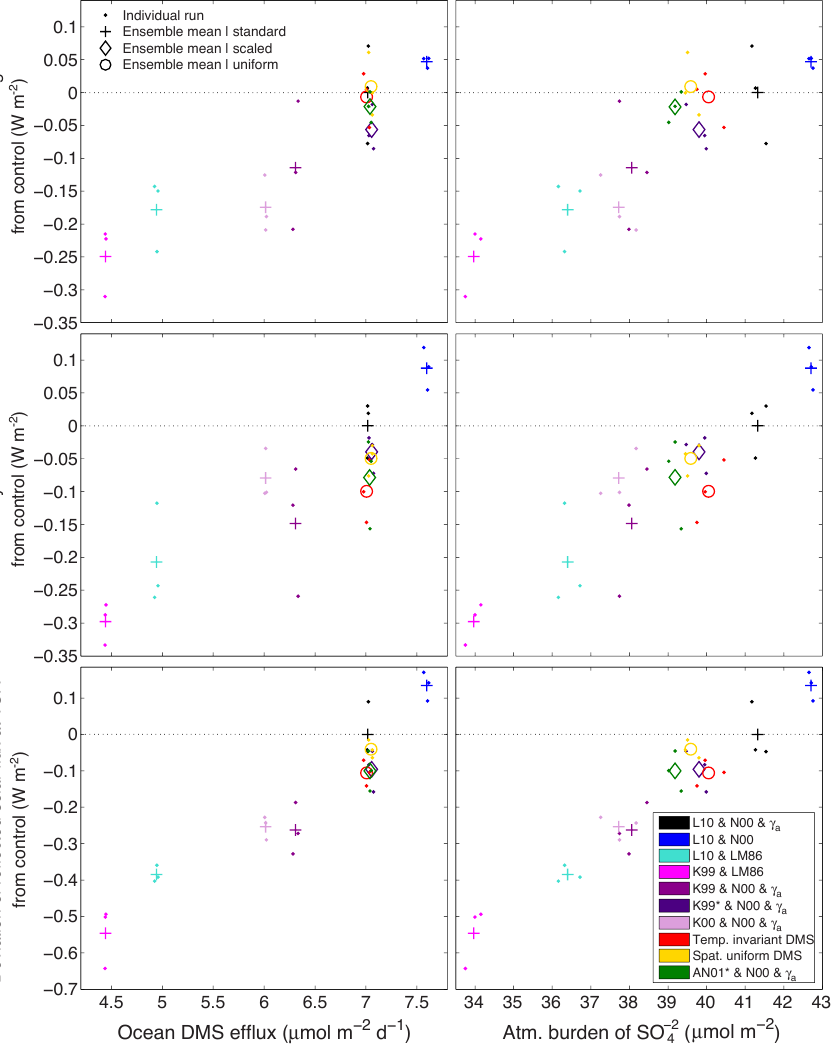
Figure 8. Deviation in global means of cloud forcing (upper panels), clear-sky reflected (middle panels), and total reflected irradiance (lower panels) at TOA from control plotted against global- and annual-mean ocean DMS flux (left) and global- and annual-mean atmospheric burden of SO 2 − (right). Symbols are as in Fig. 4